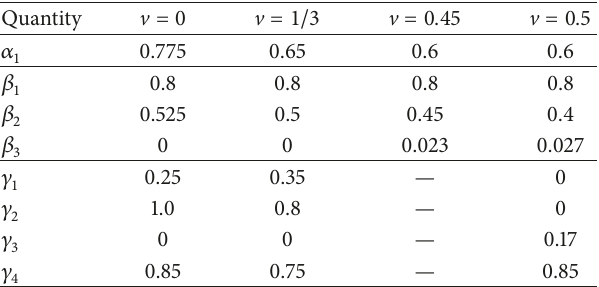
Table 2: Values for fitting parameters of 𝛼 1 , 𝛽 𝑖 , and 𝛾 𝑖